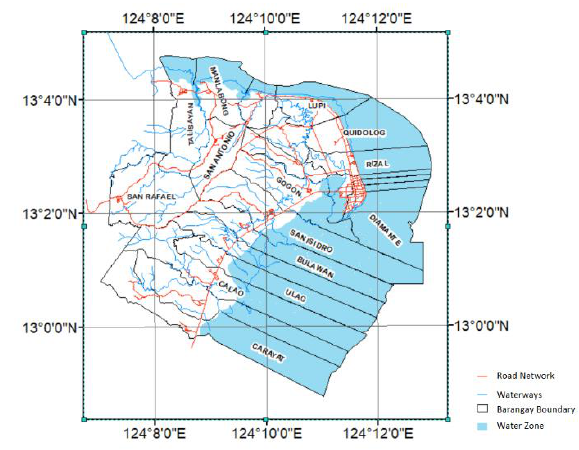
Figure 4 . Ecosystem (ecological zone)